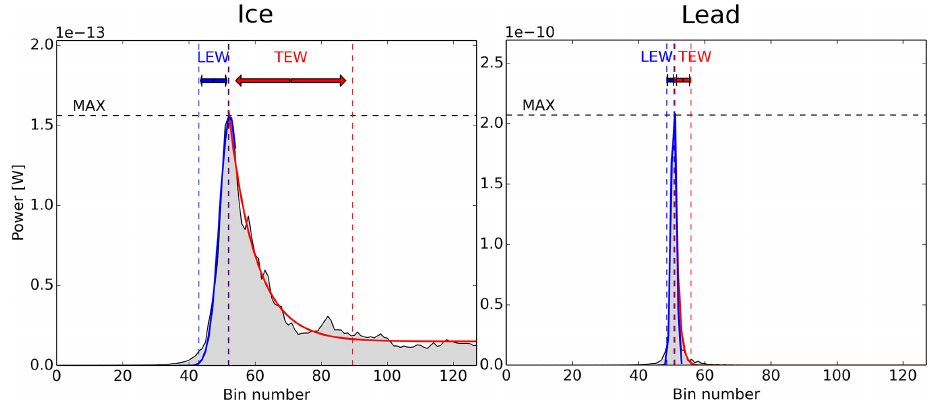
Figure 1. Typical CryoSat-2 waveforms from ice (left panel) and a lead (right panel). The definition of the leading edge width (LEW), trailing edge width (TEW) and maximum power (MAX) are illustrated, while the pulse peakiness (PP) is inversely proportional to the gray areas that normalized waveforms would have. The bin number can be converted into delay time. Note the different scaling factors of the y axis ( × 10 − 13 and × 10 − 10 for the ice and lead waveform, respectively).